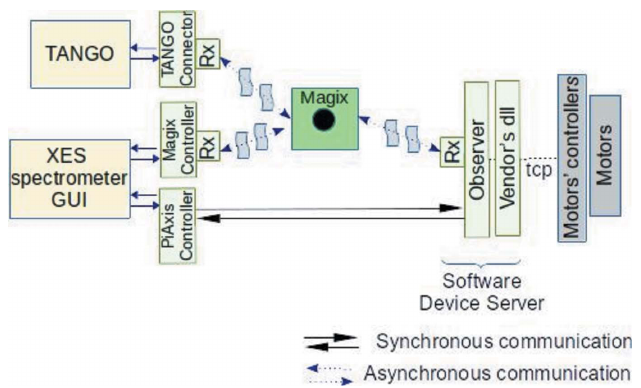
Figure 7 Control system implementation for the XES spectrometer. The software components may communicate both asynchronously and synchronously with other microservices via message’s flow which is used to transfer